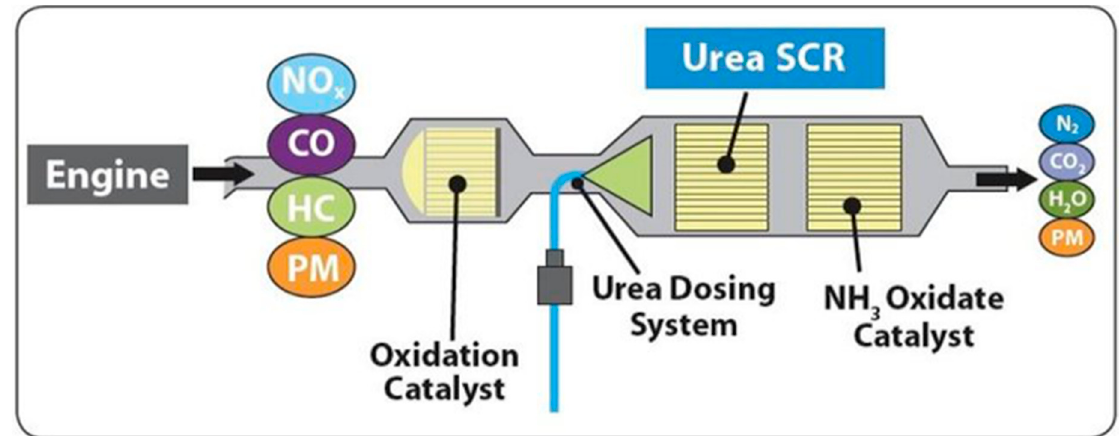
Figure 8. Schematic diagram of Selective Catalytic Reduction (SCR) geometry.